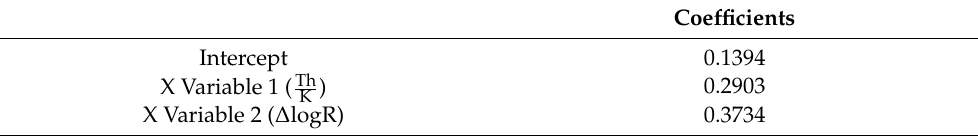
Table 5. Results of multivariate fitting of core TOC, Th/K, and ∆ log R in well